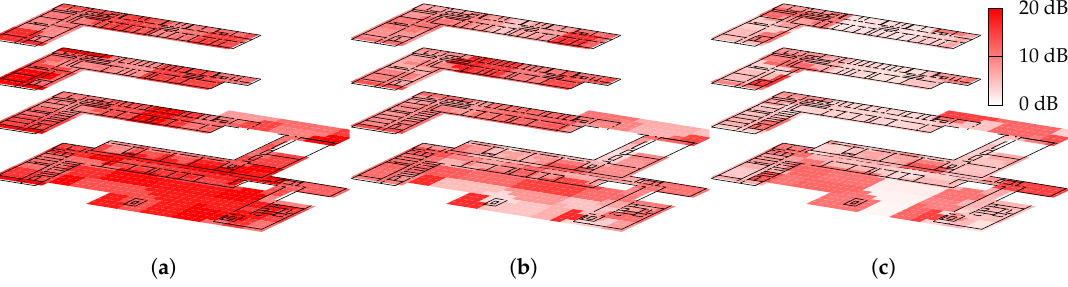
Figure 5. At every of the 121 reference measurements, more than one AP is visible, and for for every visible AP, there is a difference between model estimated and real-world signal strength. The three figures depict the highest among those errors around the location of each reference measurement. While optimization is able to reduce the average error, local maxima remain due to over-adaption. ( a ) empiric params; ( b ) optimization 3; ( c ) model per